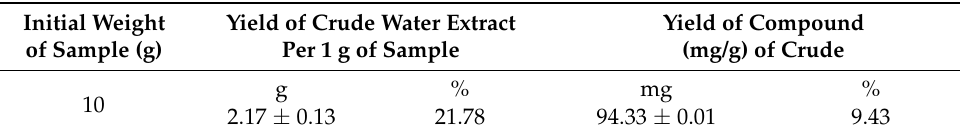
Table 1. Yield of the isolated compound,